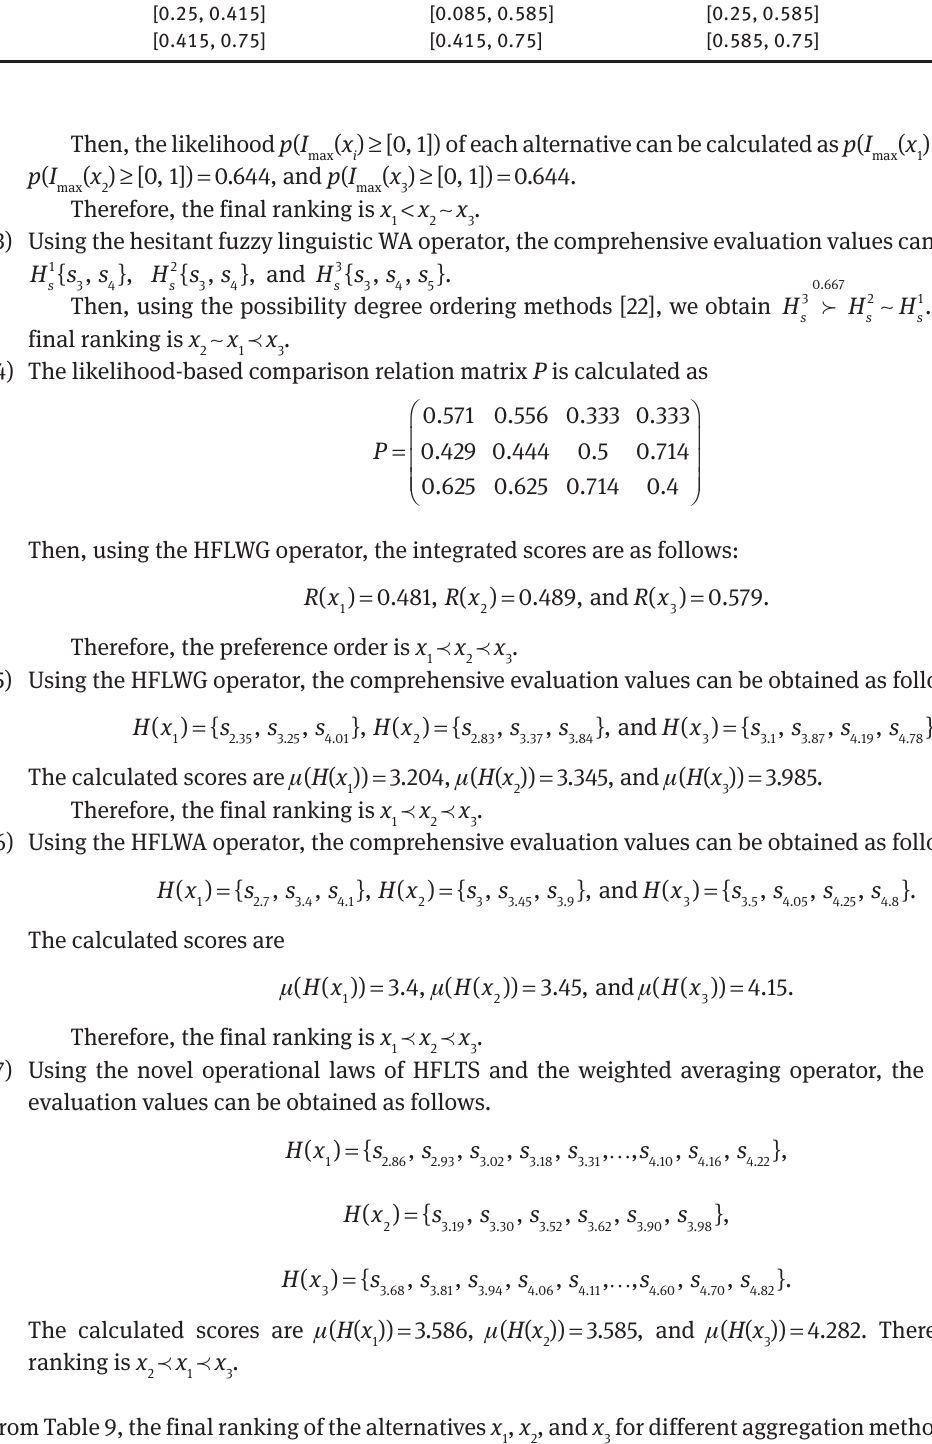
From Table 9, the final ranking of the alternatives x The decision-making results of M1, M2, and M3 lack distinction because M1 and M2 are based on the enve- lope of the HFLTS and trapezoidal fuzzy numbers, respectively, which may result in a loss of information.